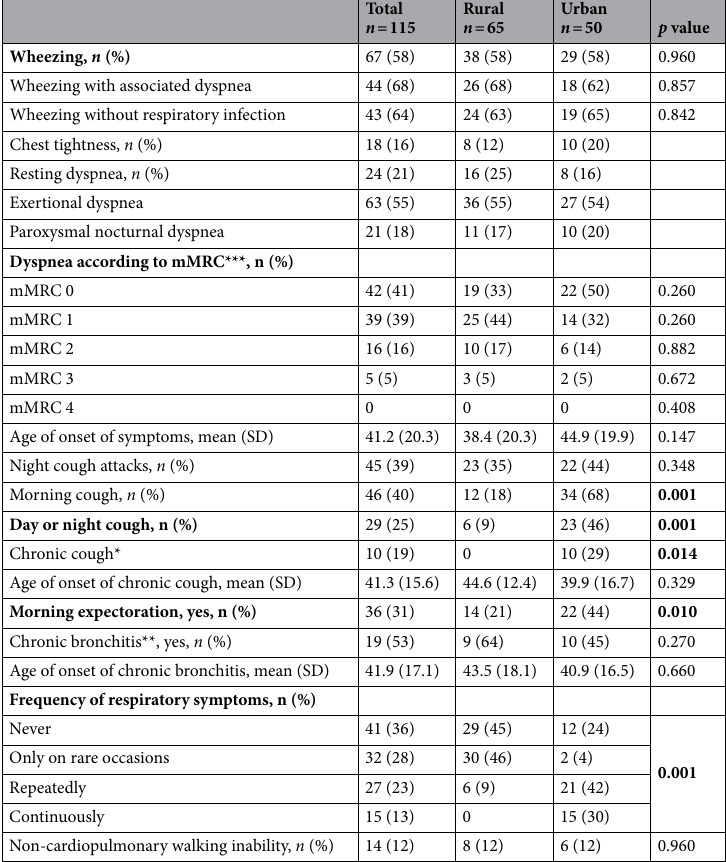
Table 4. Respiratory symptoms of asthmatic individuals included according to Q1. * Chronic cough duration longer than three months; ** Chronic bronchitis Cough and expectoration lasting more than three months for two years in a row; *** mMRC Modified Medical Research Council. SD Standard deviation. Significant values are in